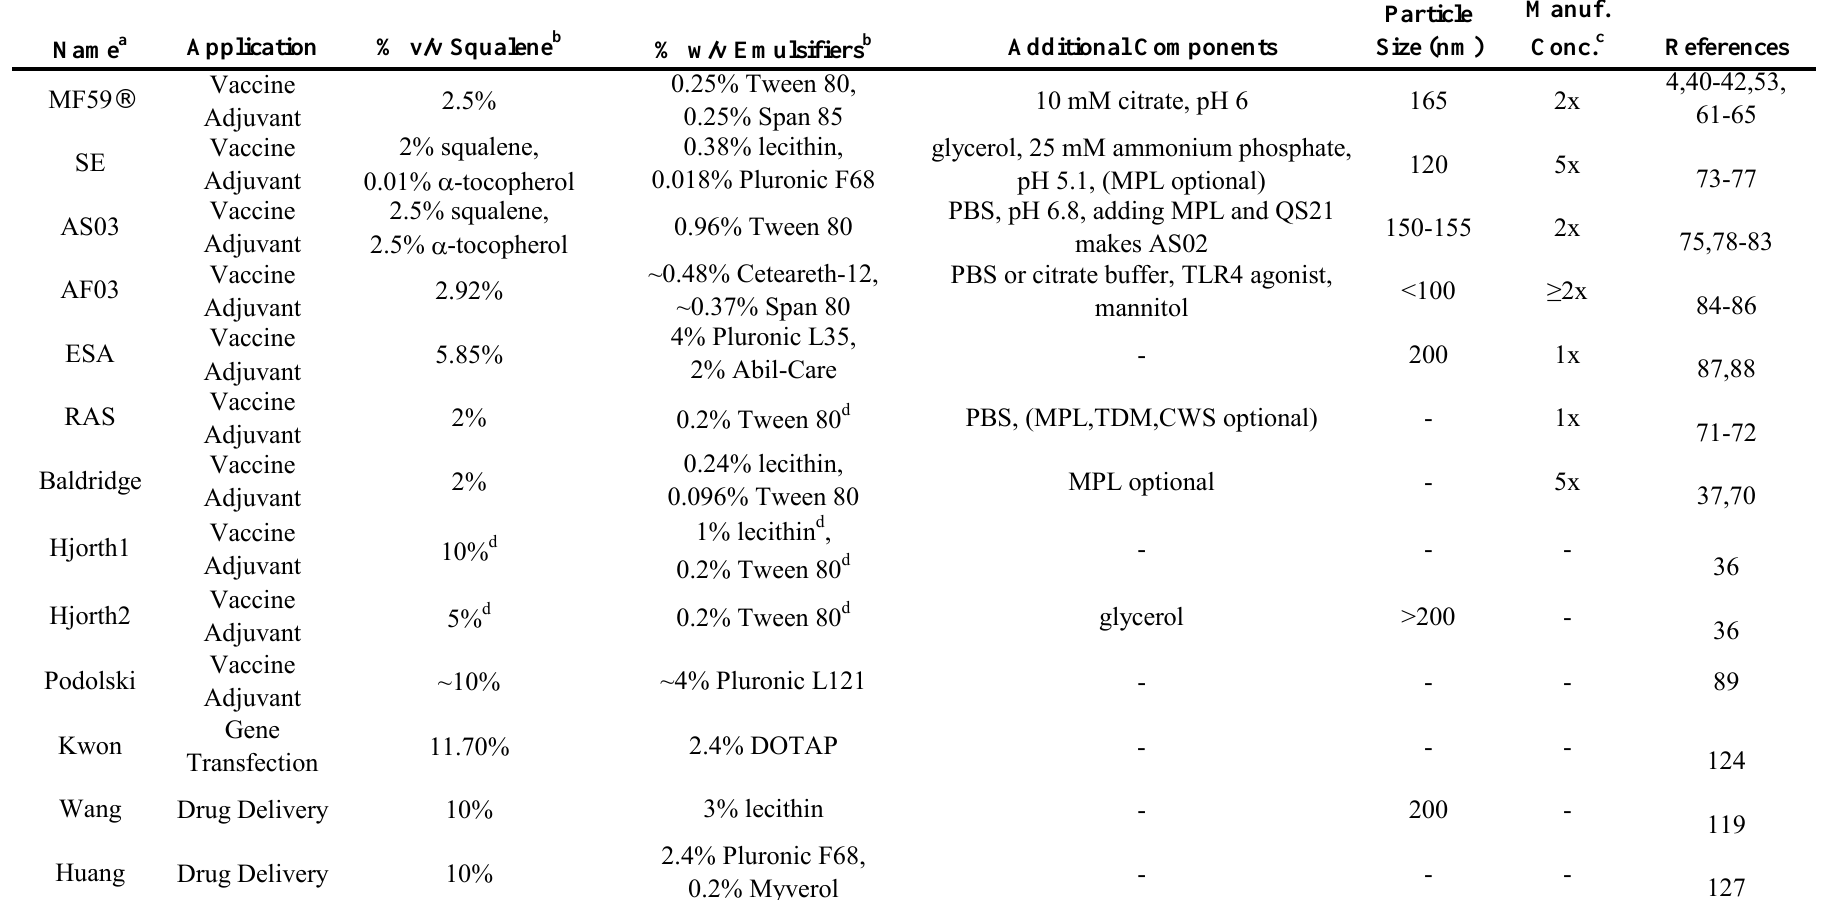
Table 2. Composition of squalene oil-in-water parenteral